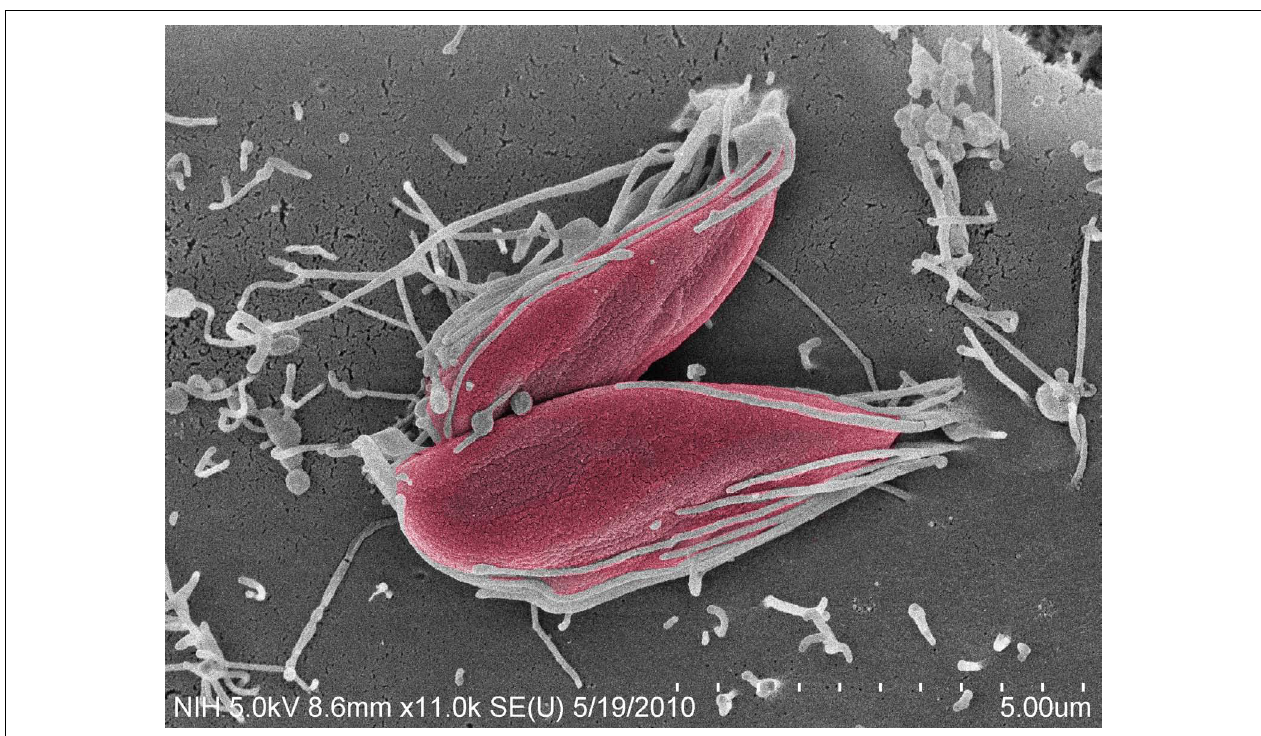
FIGURE 1 | Trypanosoma cruzi G strain amastigotes interact with microvilli on the surface of HeLa cells. Parasites (colored in red) imaged by